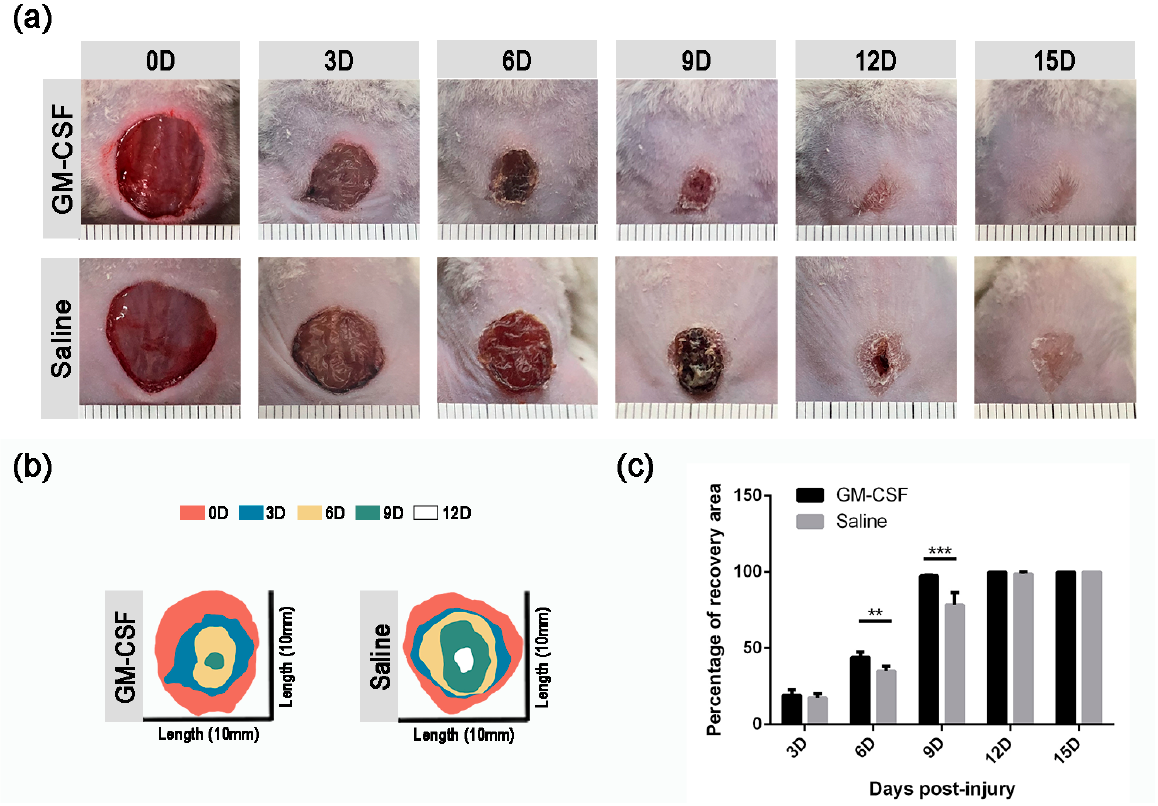
Figure 6. Wound healing of saline- and GM-CSF-injected mice. ( a ) Macroscopic appearance of wound sites from GM-CSF-treated and control mice. ( b ) Schematic diagram of injury site changes over time. ( c ) Quantification of the percentage of recovery area rate ( n ≥ 3. ** p < 0.01, *** p < 0.001. Data presented as mean ± SD). Table 2. Statistics of healing rate in Saline- and GM-CSF-injected mice.